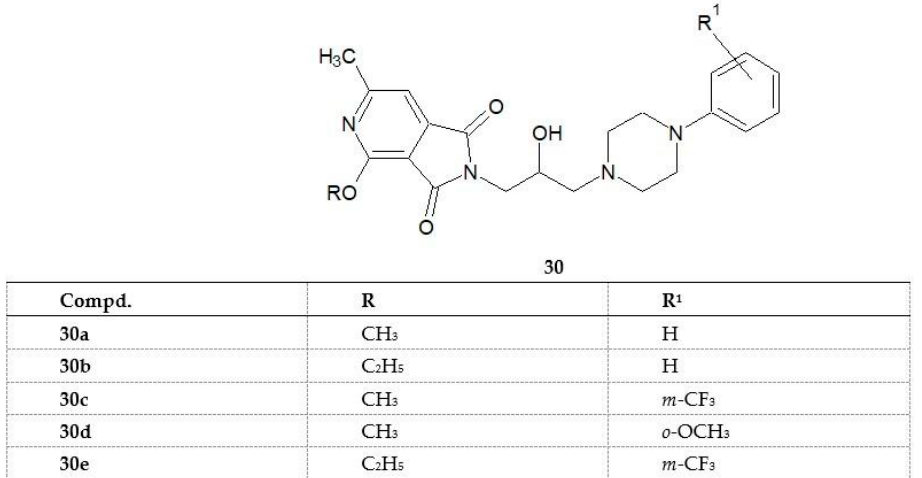
Figure 24. New derivatives of 2,3 ‐ dihydro ‐ 4 ‐ methoxy(ethoxy) ‐ 6 ‐ methyl ‐ 1,3 ‐ dioxo ‐ 1 H ‐ pyrrolo[3,4 ‐ c ]pyridine 30a ‐ e [32].